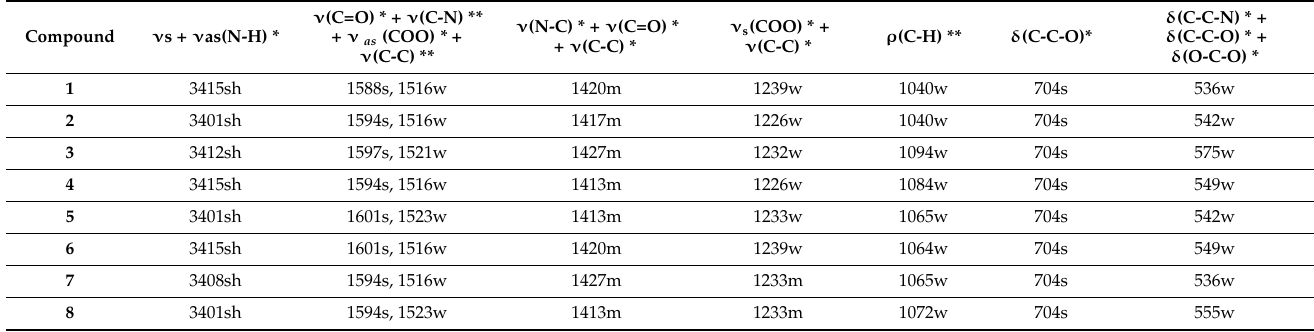
Table 2. FTIR spectra assignment for complexes 1 – 8 .